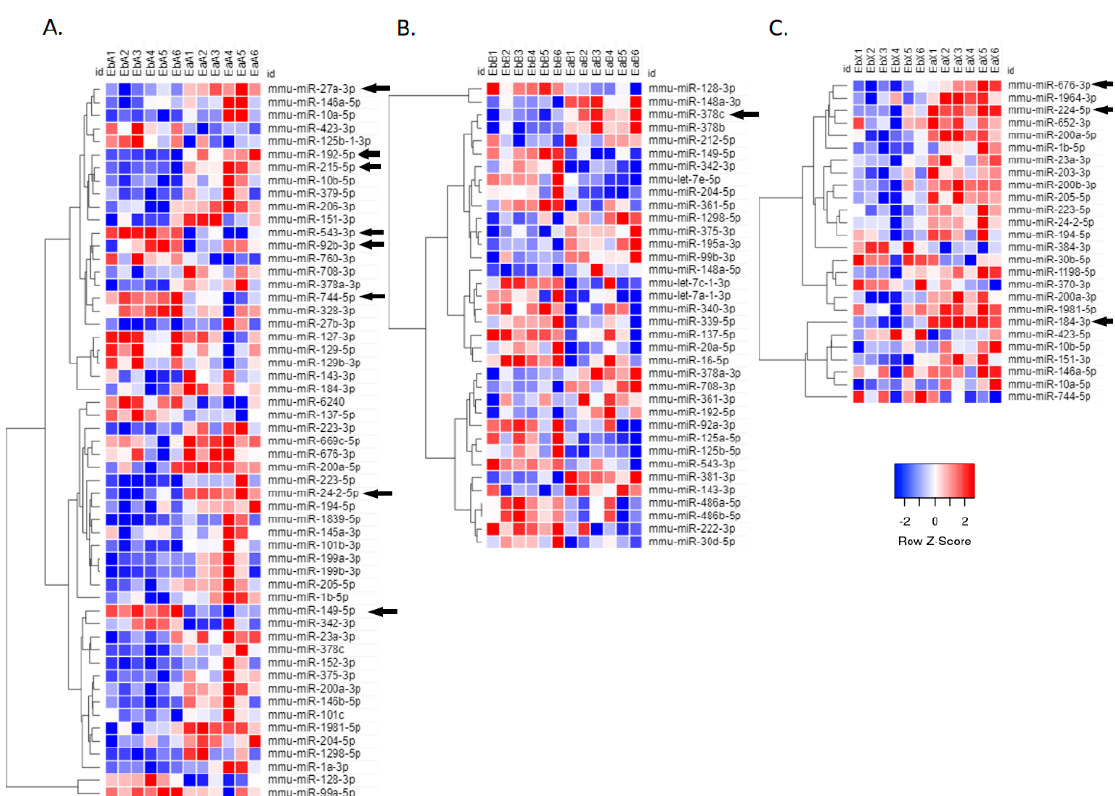
Figure 2. Exosomal miRNA expression affected by chemopreventive agent treatments. ( A ) Heat map showing differentially expressed exosomal miRNA affected by AZD6244 treatment. ( B ) Heat map showing differentially expressed exosomal miRNA affected by Budesonide treatment. ( C ) Heat map showing differentially expressed exosomal miRNA affected by XL-147 treatment. Expression values are shown as log2 transformed read counts and the criterion is raw p -value < 0.05. The significant differentially expressed miRNAs shown in Table 2 (FDR < 0.05) are labeled by arrows. Low expression is indicated by blue, and high expression is indicated by red.